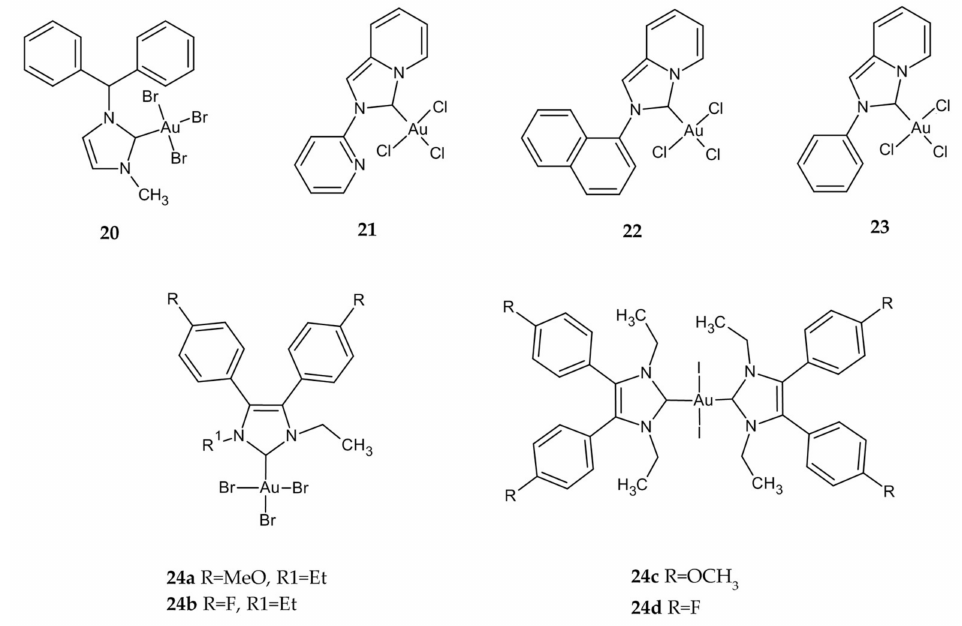
Figure 9. NHCs Au(III) derivatives 20 – 24